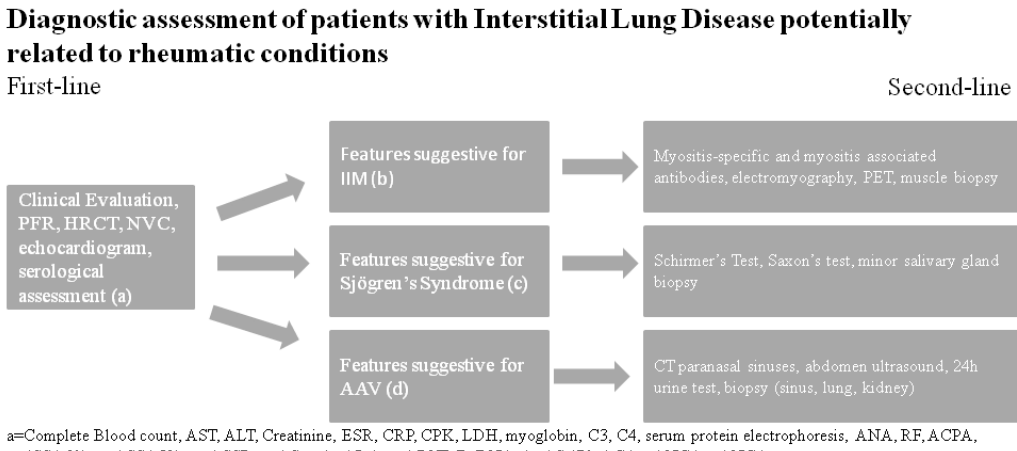
Figure 4. Our methodology in the diagnostic assessment of patients with interstitial lung disease.